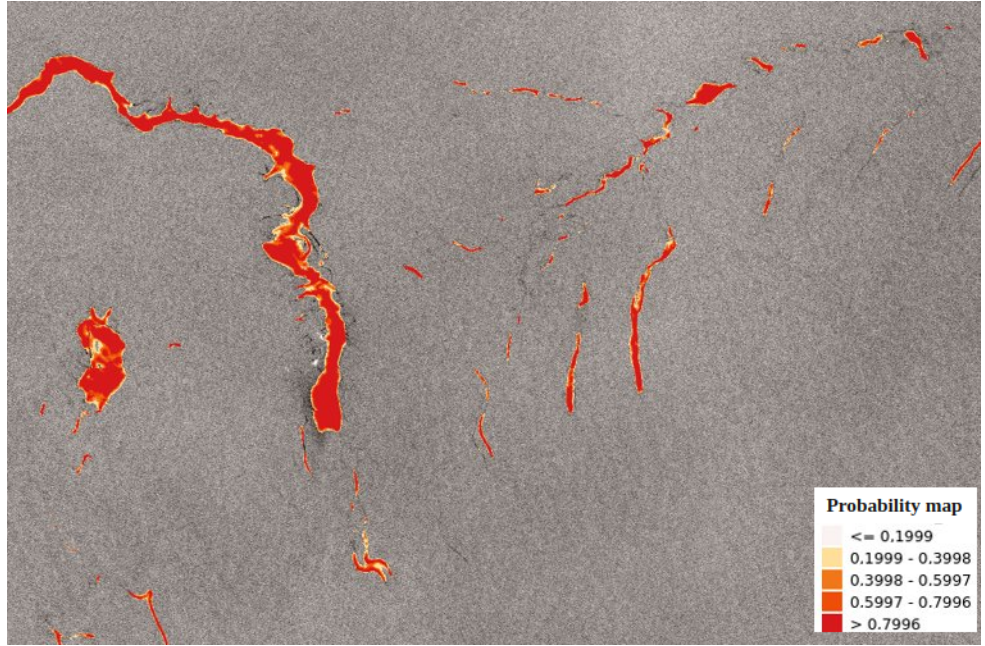
Figure 20. Example of a prediction probability map of the improved version of FC-DenseNet model. For a larger-scale investigation, these slick probability maps are considered to plot the ROC curves aggregating all the predictions on the test database for the different late fusion models. ROC curves for the fusion experiments are shown in Figure 21.